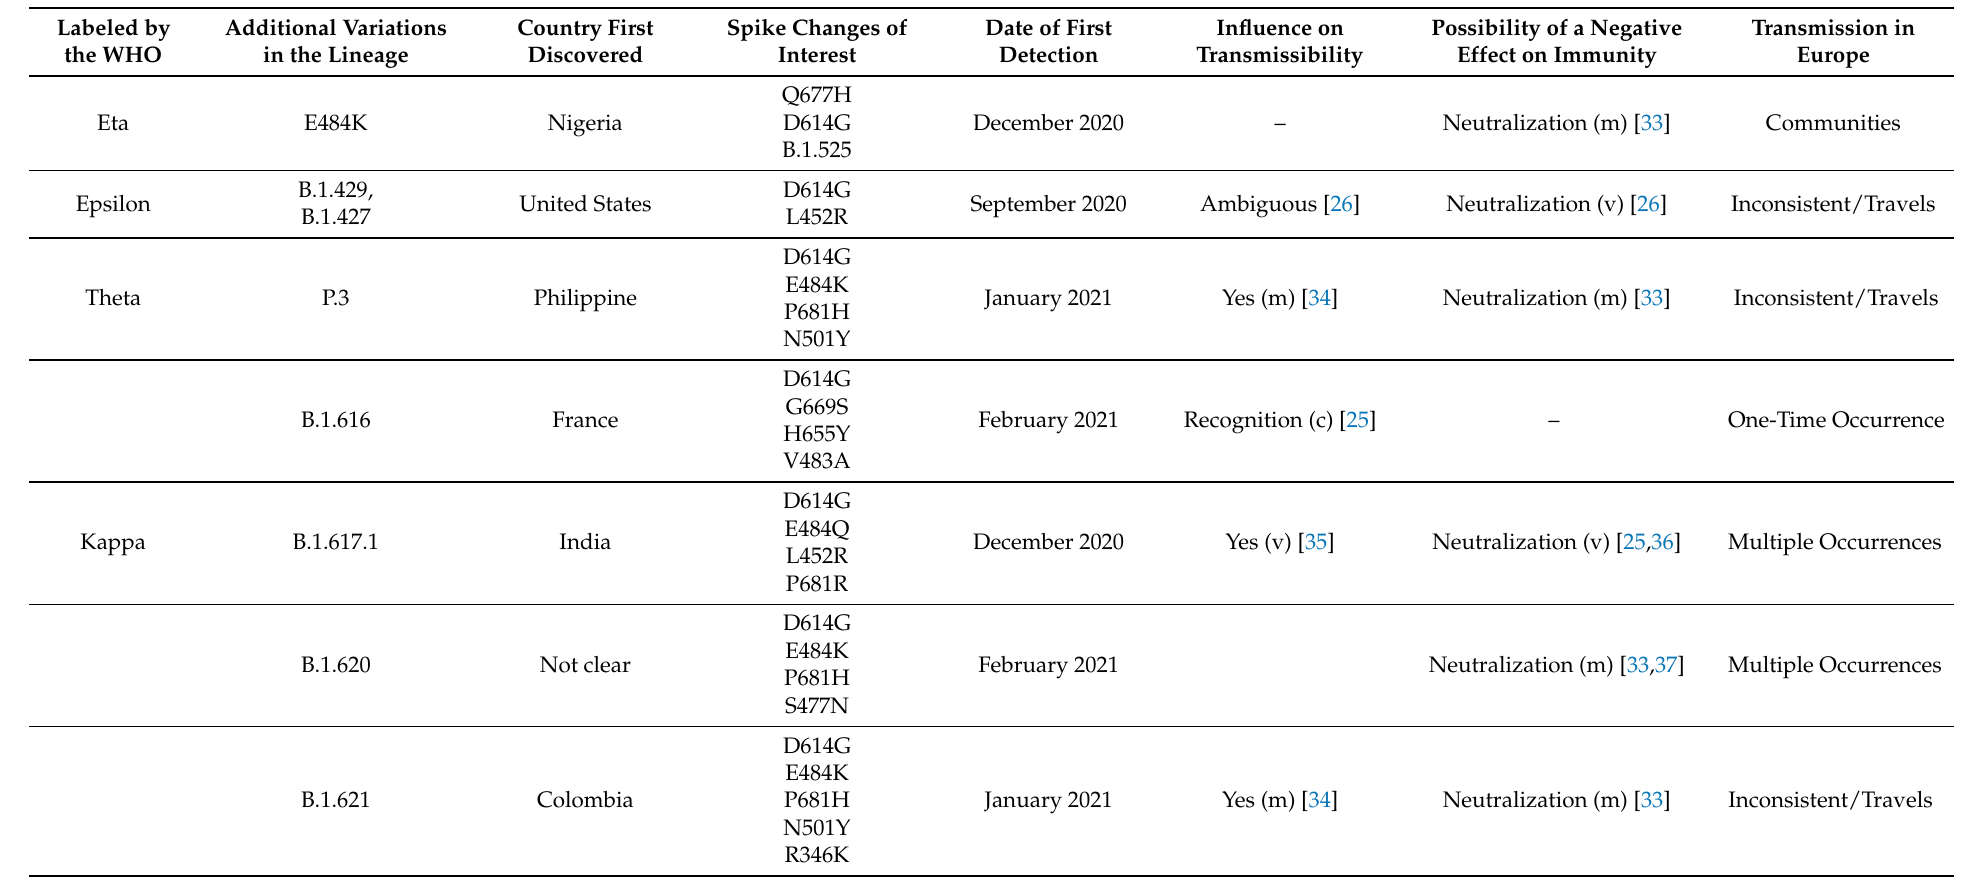
Table 2. Variants of Interest (VOI)